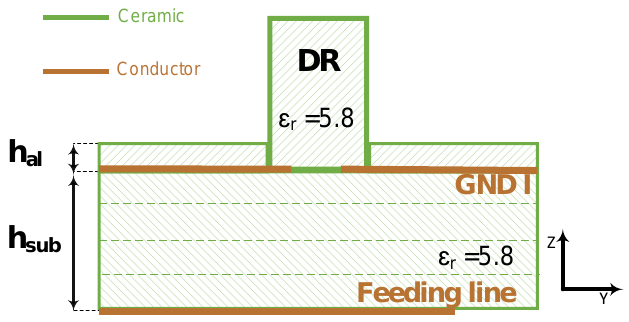
Figure 6. Schematic of the proposed stack with a grooved superstrate for the CDRA.